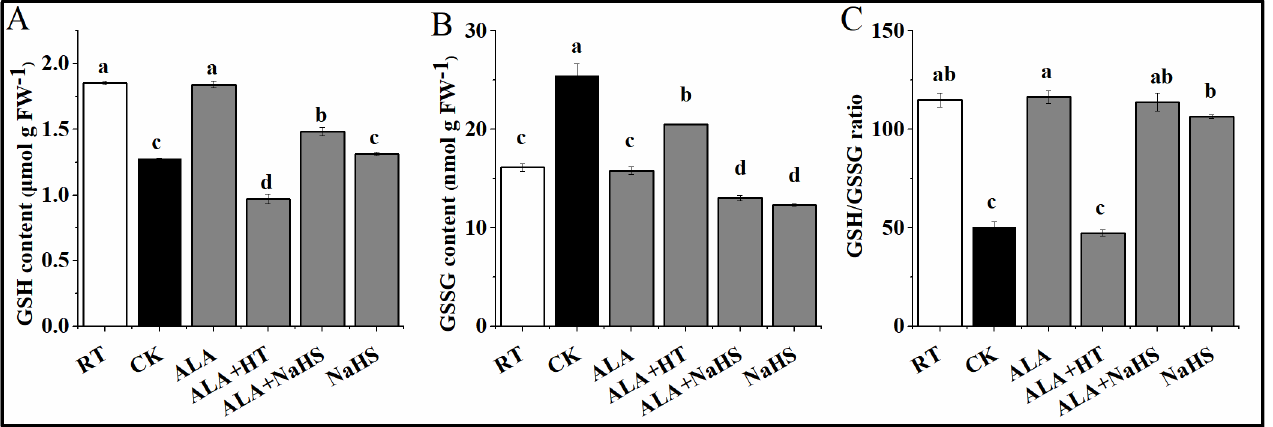
Figure 4. Effects of ALA and/or H 2 S on the contents of GSH ( A ), GSSG ( B ), and GSH/GSSH ratio ( C ) under chilling stress for 24 h. The error bars are the standard errors for three independent tests. Different letters show significant differences ( p < 0.05) based on Duncan’s test.